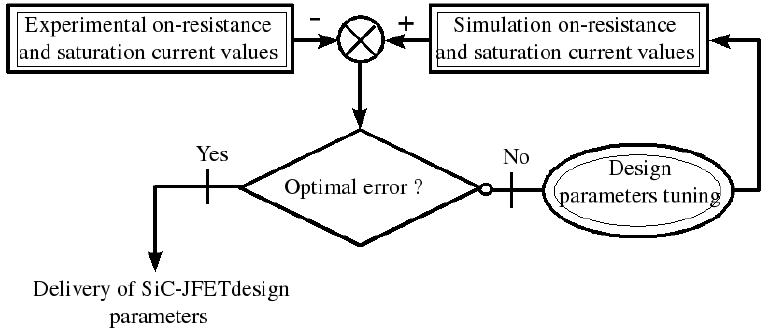
Figure 10. Flow char algorithm of SiC-JFETs design parameters identification.